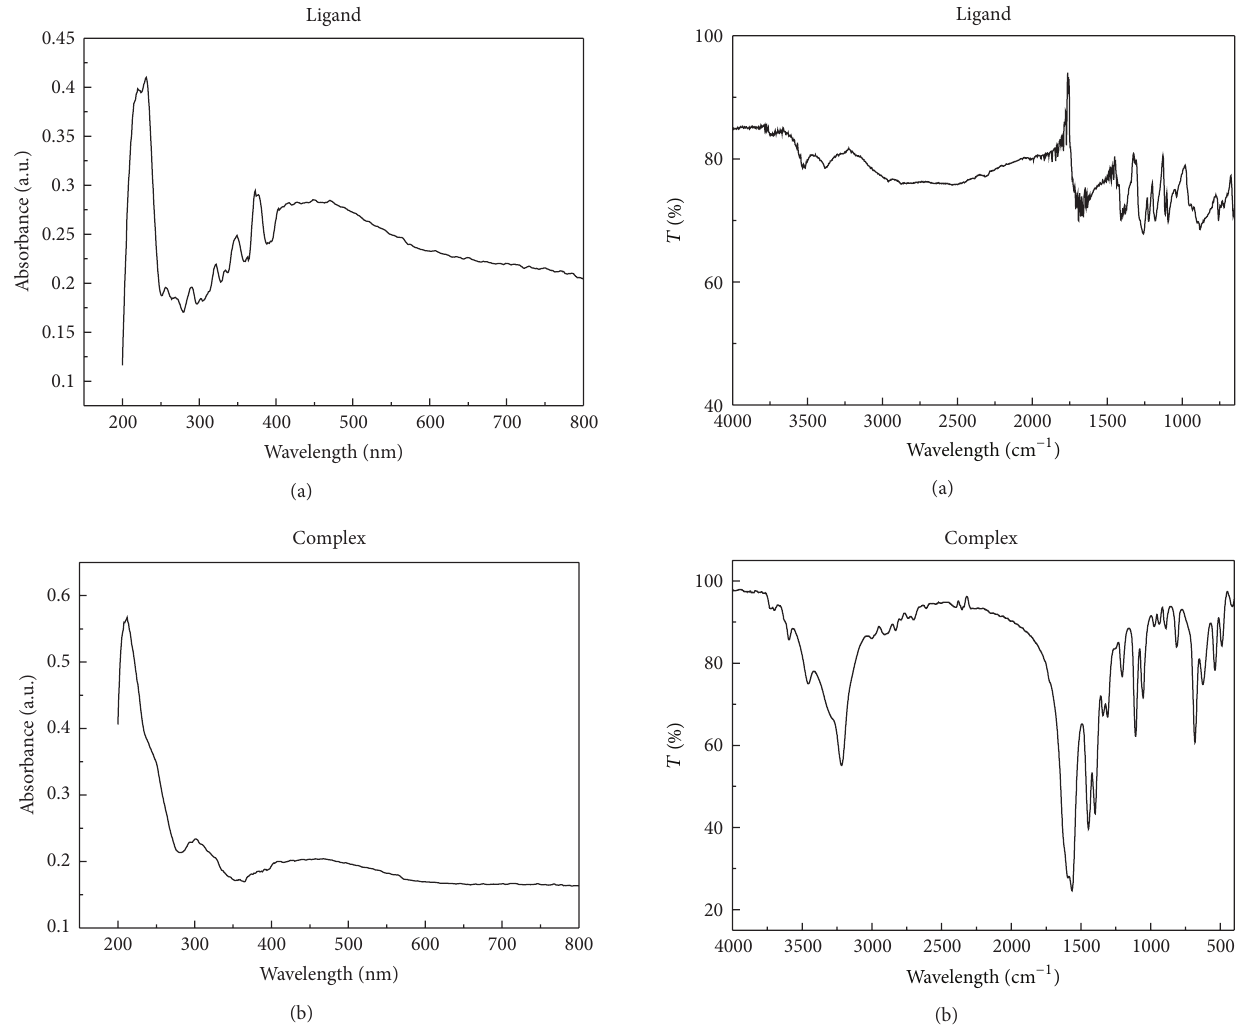
Figure 1: UV-Vis absorption spectra for the ligand and the complex.